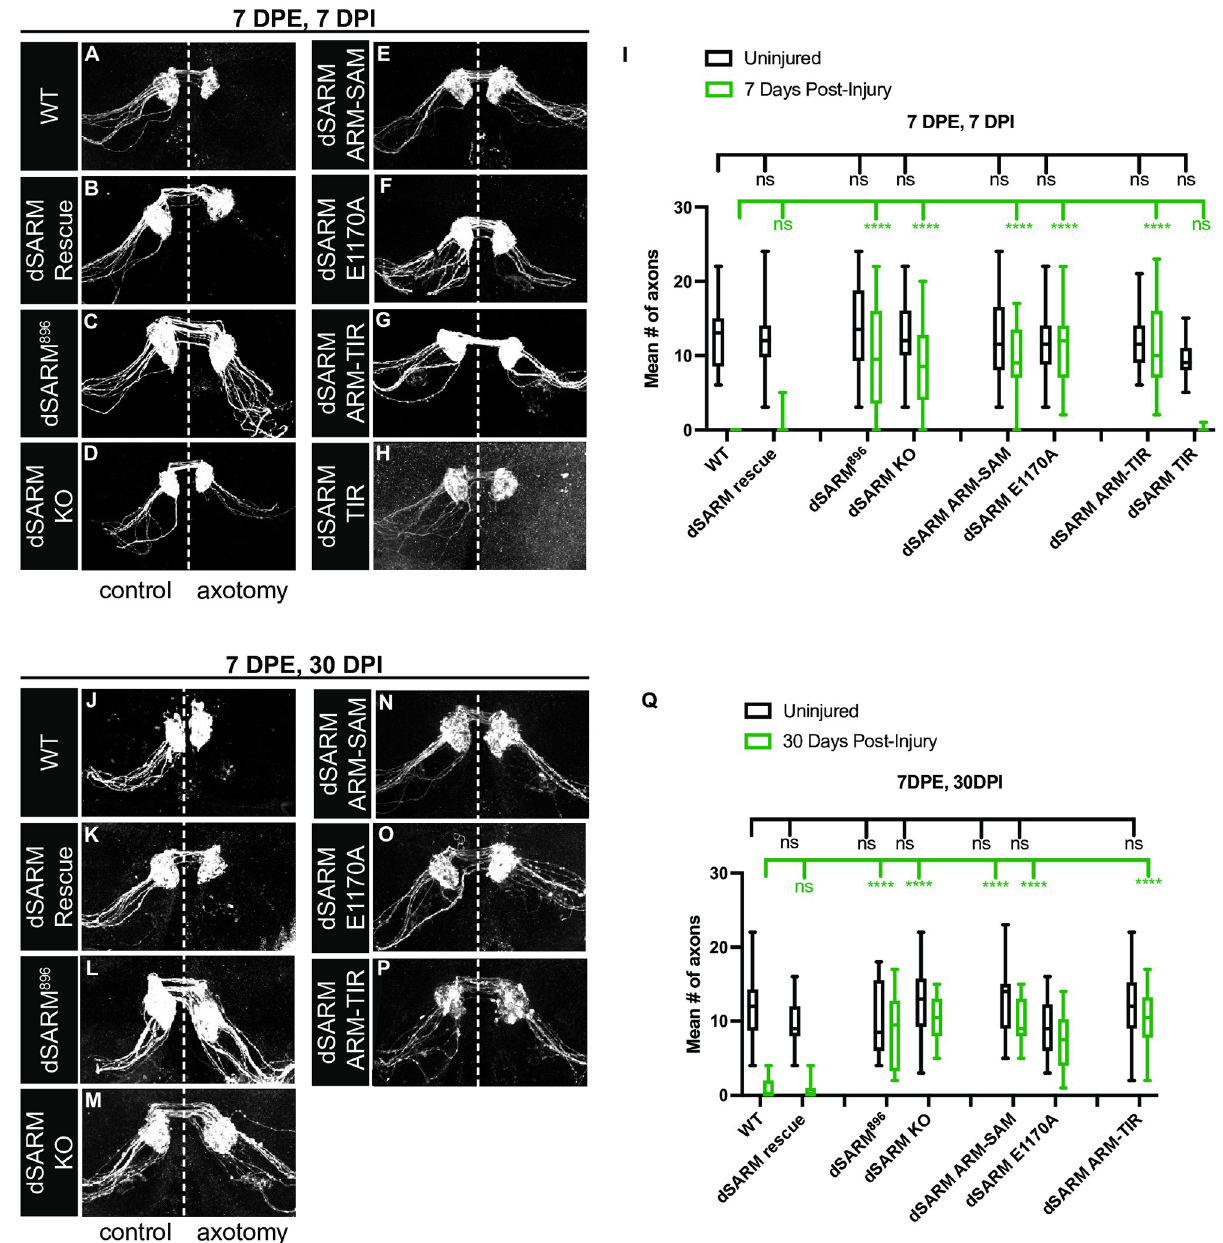
Fig 2. Loss of dSARM’s NADase activity affords long-lived protection of injured ORN axons. (A-H) Representative z-projections of OR22a ORNs of the indicated genotypes labeled with anti-GFP. The control side is on the left and the axotomized side is on the right. These animals were injured 7-day post-eclosion (7 DPE) and analyzed at 7-days post-injury (7 DPI). (I) Quantification of mean number of axons on uninjured control (black) and 7 days post-injury (green). Mean number of axons on uninjured control, injured sides: wild type (FRT2A) (n = 25): 12.32, 0.00; dSARM 896 (n = 24): 13.92, 9.75; dSARM Rescue (n = 30): 12.33, 0.40; dSARM KO (n = 32): 12.56, 8.34; dSARM ARM-SAM (n = 34): 12.42, 9.00; dSARM E1170A (n = 24): 11.71, 11.26; dSARM TIR (n = 35): 9.46, 0.04; dSARM ARM-TIR (n = 24): 11.76, 10.89. (J-P) Representative z-projections of OR22a ORNs of the indicated genotypes labeled with anti-GFP. The control side is on the left and the axotomized side is on the right. These animals were injured 7 DPE and analyzed at 30 DPI. (Q) Quantification of mean number of axons on uninjured control (black) and 7 days post-injury (green). Mean number of axons on uninjured control, injured sides: wild type (FRT2A) (n = 30): 11.77, 1.10; dSARM 896 (n = 20): 9.95, 8.80; dSARM Rescue (n = 26): 9.27, 0.77; dSARM KO (n = 28): 12.61, 10.29; dSARM ARM-SAM (n = 22): 12.81, 10.00; dSARM E1170A (n = 27): 9.32, 7.32; dSARM ARM-TIR (n = 22): 11.91, 10.86. Error bars represent min and max data points. n.s. is not significantly different. ���� , p < 0.0001.